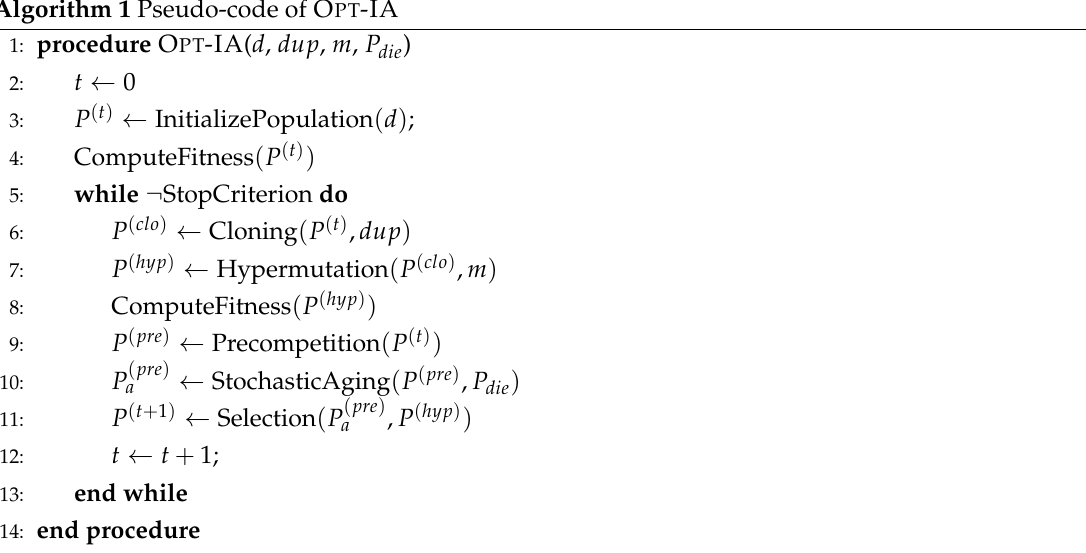
Algorithm 1 Pseudo-code of O PT